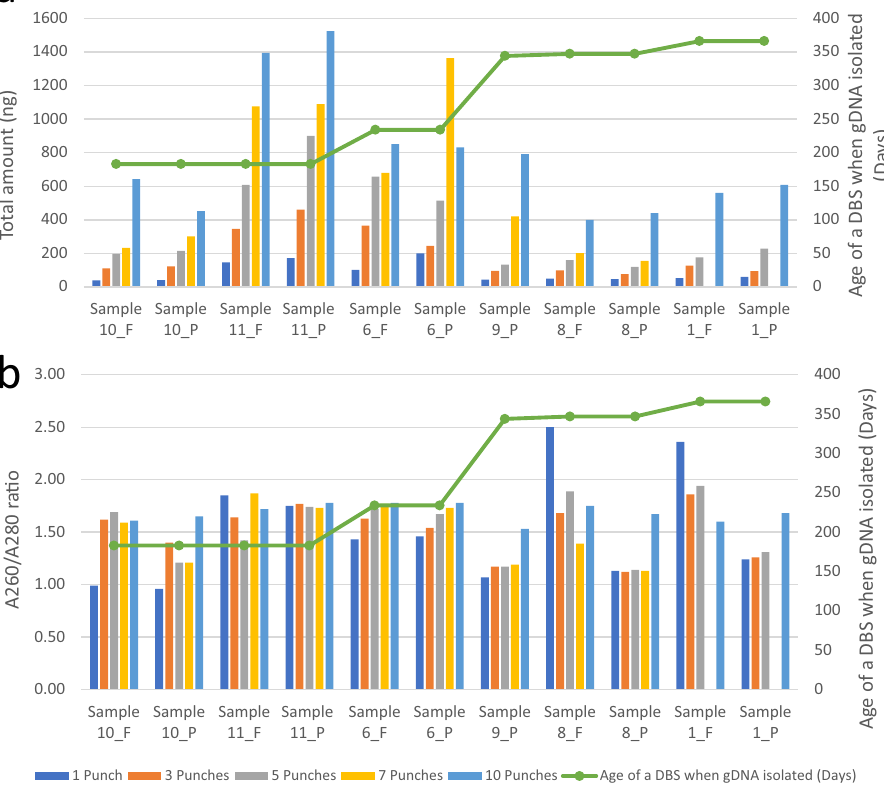
Fig. 2 Relationship between genomic DNA yield, purity, and number of blood spot punches used for DNA extraction. Relationship of number of DBS punches and genomic DNA yield ( a ) and A260/A280 ratio ( b ) for 11 DBS. Samples were 1, 6, 8, 9, 10, and 11. DBS were generated with both FTA and PC fi lter papers, with the exception of sample 9 (PC gDNA per extraction. The DNA yield decreased with the length of storage of manufactured DBS (Fig. 2a). The A260/A280 ratio did not vary with age of DBS (Fig. 2b).